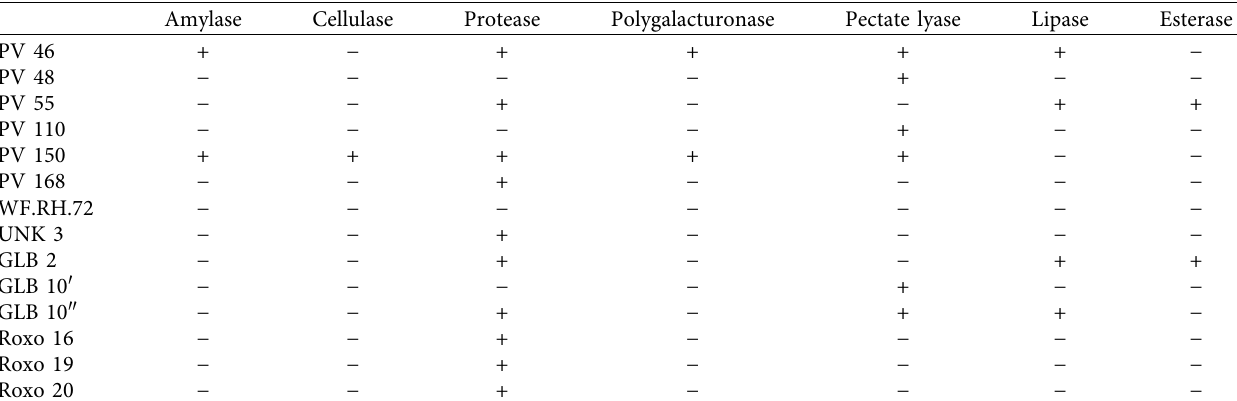
Table 3: Enzymatic activity of bacteria isolated from Polygala paniculata